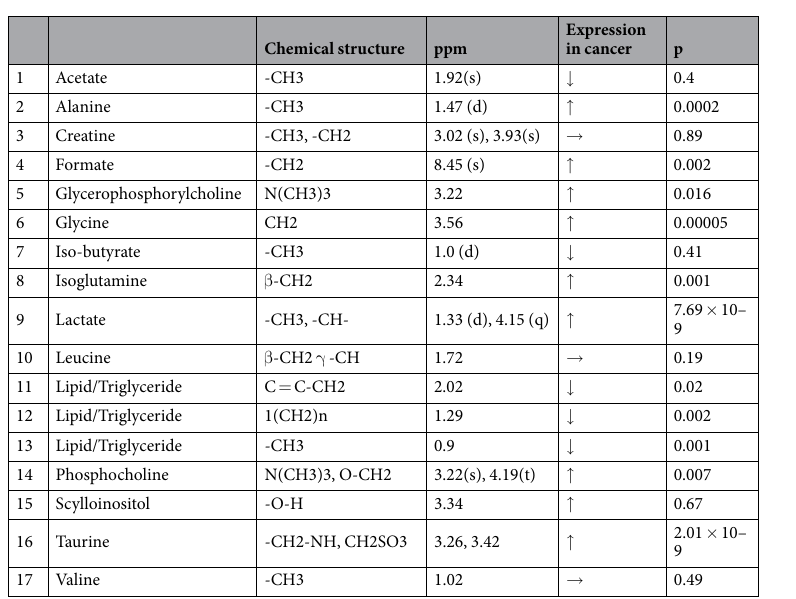
Table 3. Summary of significant metabolites, their observed trends in terms of abundance ( ↑ , ↓ , ↔ ) with corresponding p-values, their chemical formulae and chemical shift